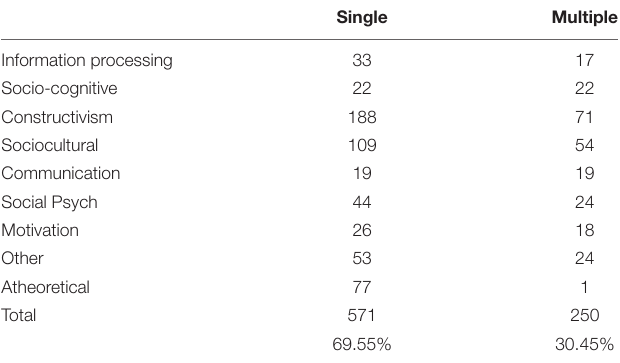
TABLE 1 | Co-occurrence of theoretical